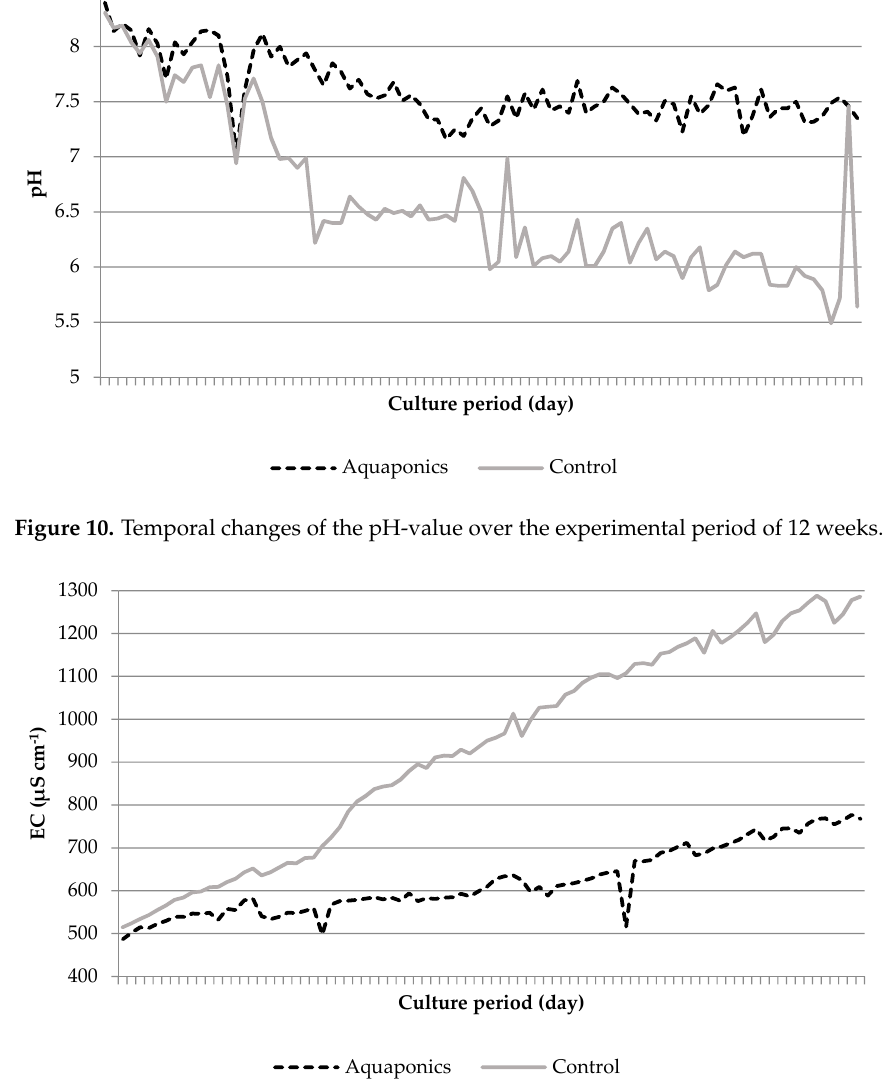
Figure 11. Temporal changes of the electric conductivity over the experimental period of 12 weeks.